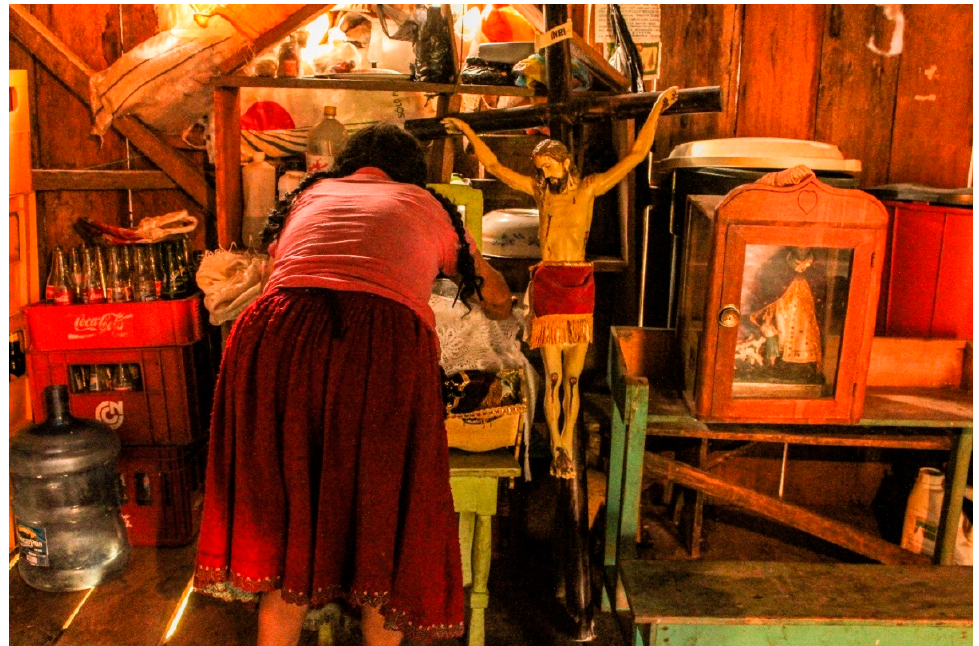
Figure 4. The settler widow with patron saint San Marcos (right in the box) and some other artefacts from the chapel which she ‘saved’ when it was demolished. Picture by author.